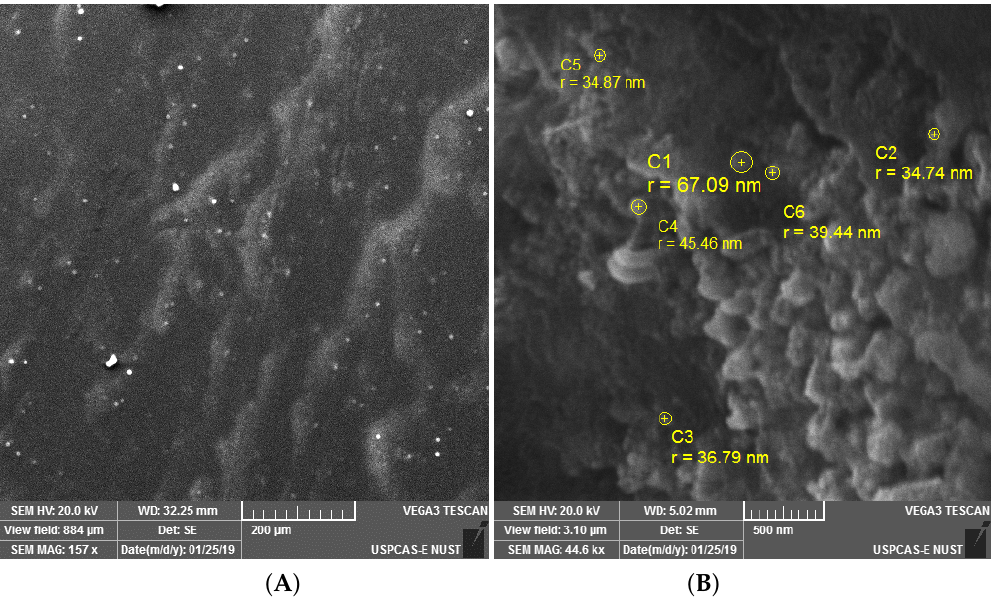
Figure 6. ( A ) SEM image of biogenic AgNPs at 157 kx and 200 µ m indicating the formation of spherical nanoparticles. ( B ) SEM image of biogenic AgNPs at 44.6 kx and 500 nm, indicating various sizes of nanoparticles.